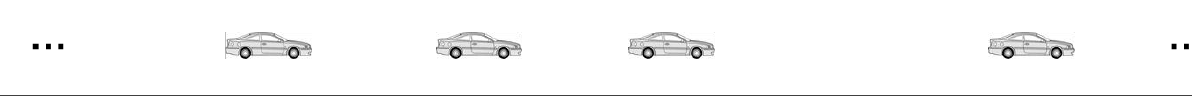
Figure 2. The continuous CA model with defining vehicles as cellular.